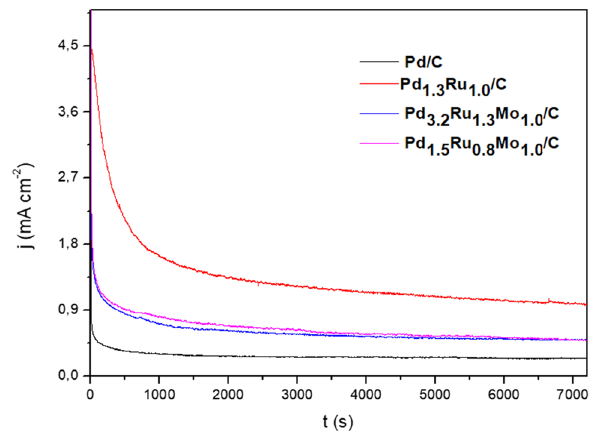
Fig. 5 Chronoamperometry curves in KOH 1.0 mol·L −1 /Ethanol solu- tion for 2